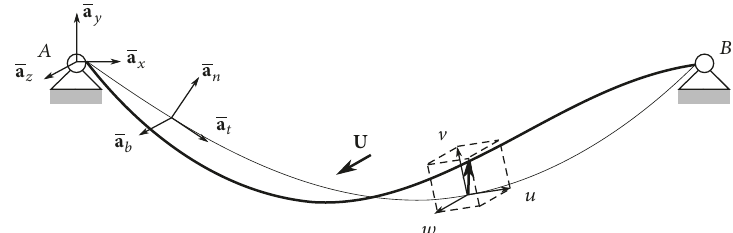
Figure 1: Shallow horizontal cable under normal wind flow. Thin line: in-plane equilibrium position under self-weight; thick line: current configuration under the action of both self-weight and